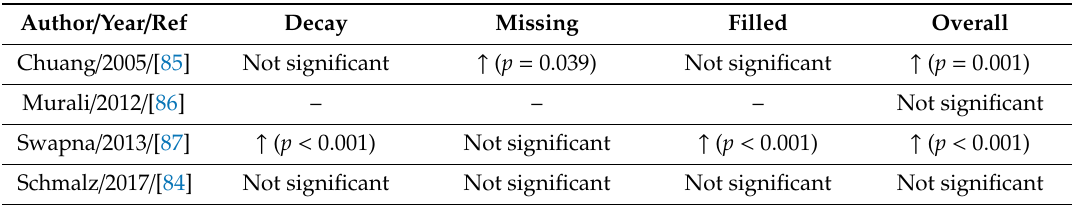
Table 5. Decayed, missing, and filled teeth (DMFT) index in hemodialysis patients with and without